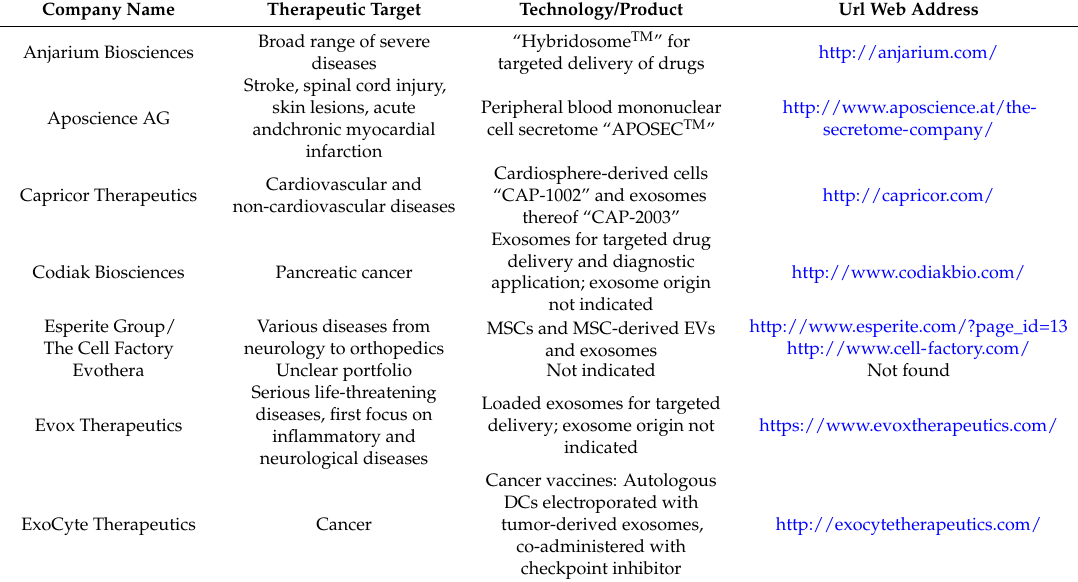
Table 1. List of companies offering exosome-/extracellular vesicle- or secretome-based services and